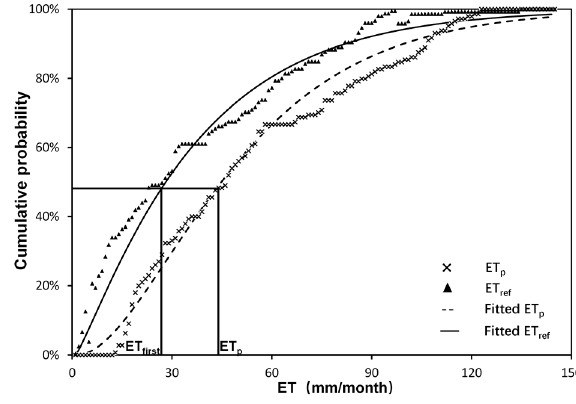
Figure 5. Schematic diagram for the first step of the correction.